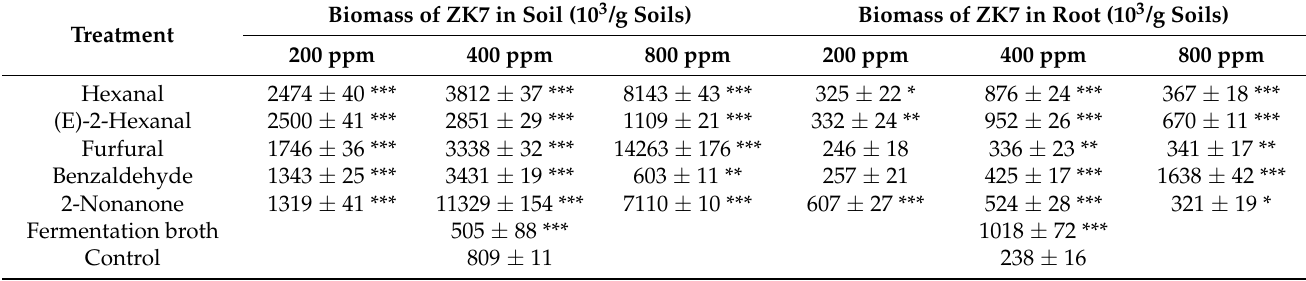
Table 8. Colonization of P. chlamydosporia ZK7 in rhizosphere soil and tomato roots with volatile